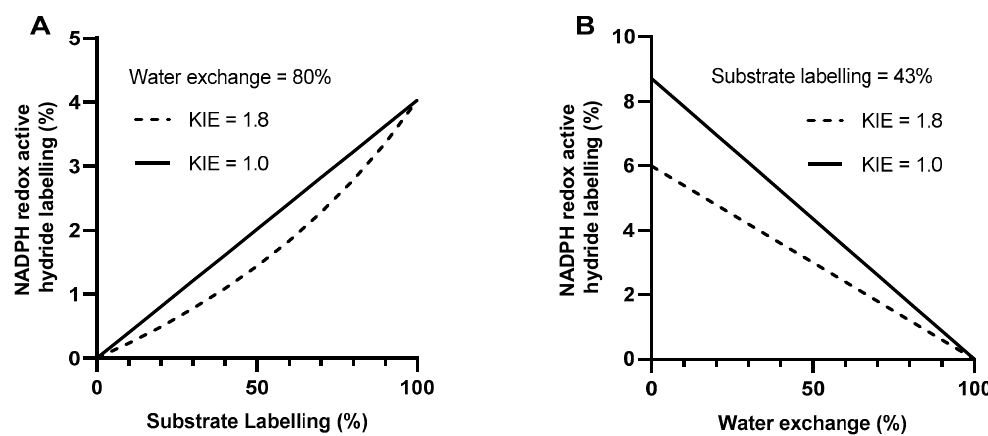
Figure 4. The simulated effect of substrate labelling ( A ) and water exchange fraction ( B ) on the NADPH redox active hydride labelling in the presence (---) or absence (–) of a deuterium kinetic isotope effect (KIE) calculated using Equations (1) and (2) (see Section 5.4). The oxPPP contribution to NADPH production was fixed at 40%. Water exchange was fixed at 80% whilst substrate labelling was varied ( A ) Substrate labelling was fixed at 43% whilst water exchange was varied ( B ) Calculations were performed using linear equations in MATLAB (see Supplementary Materials for link to code).